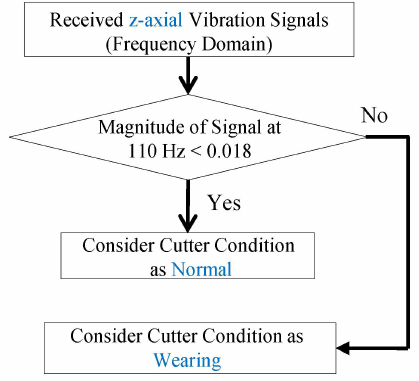
Figure 10. The criterion for monitoring the cutter’s wear condition during milling.